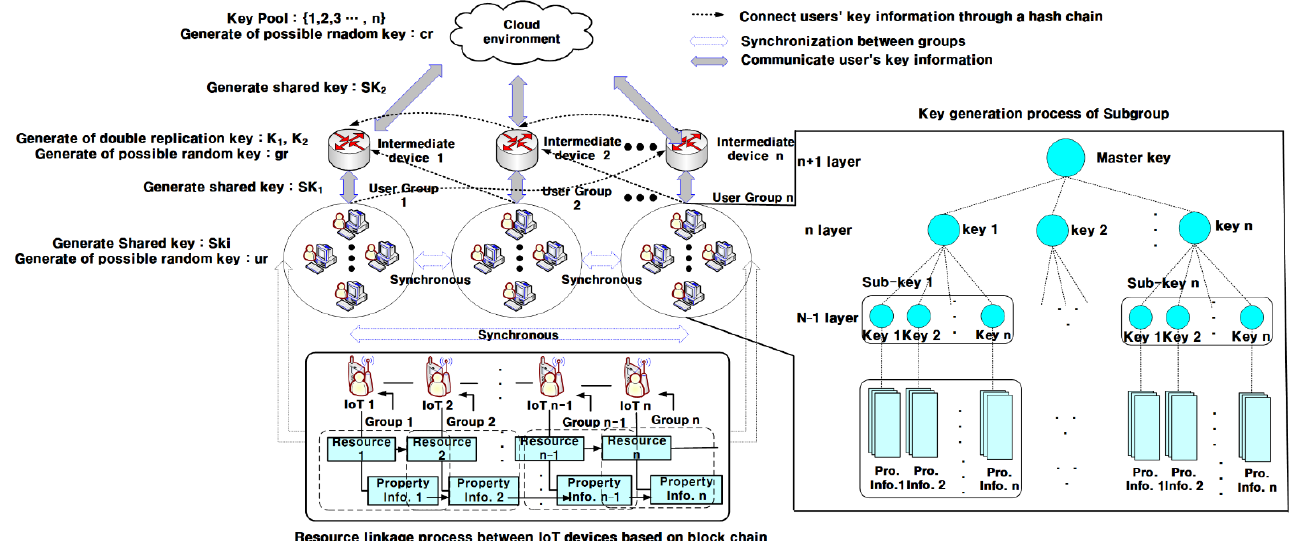
Figure 1. The overall behavioral structure of the proposed